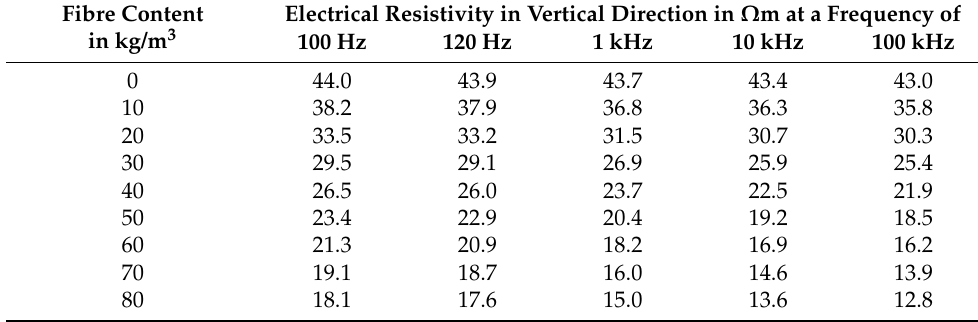
Table A26. Results of the resistivity measurements of the concrete mixture 32-60-300-00-F3. Fibre Content